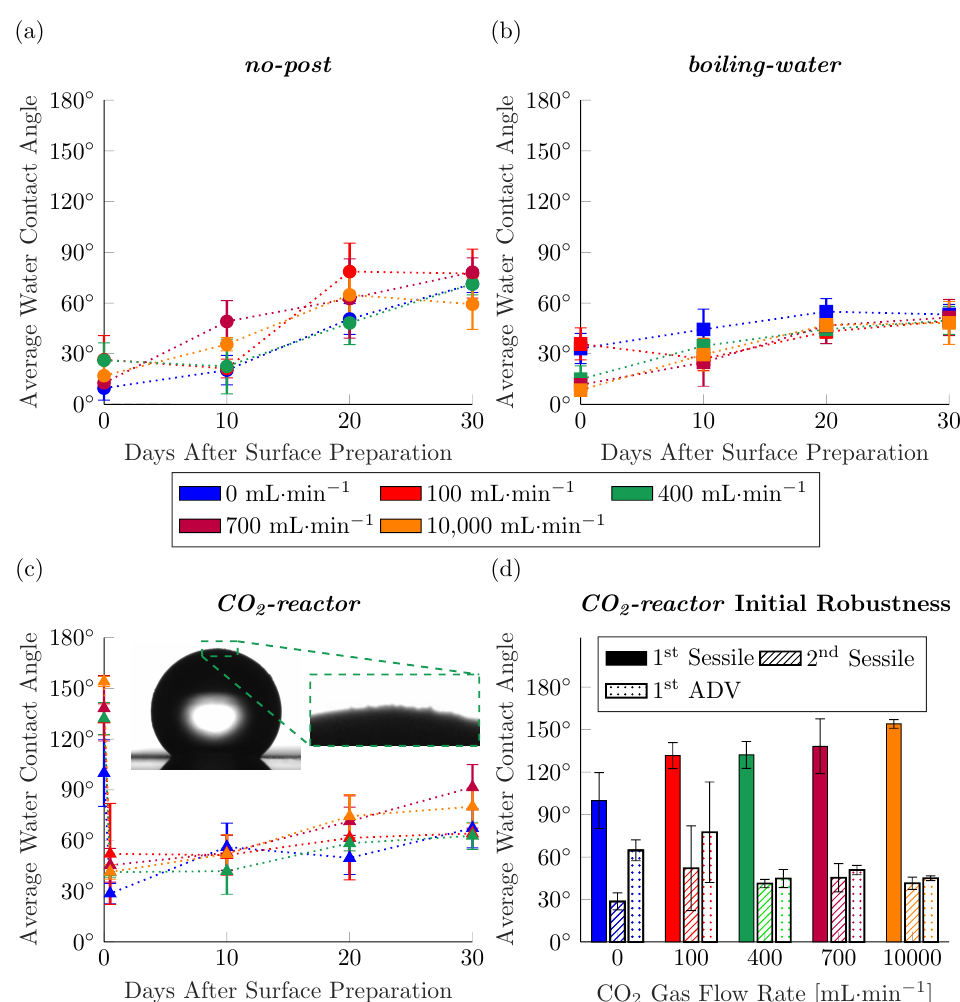
Figure 2. Average sessile water contact angle measurements taken over the 30 days following laser micromachining/post-processing on surfaces prepared with: ( a ) no post-processing step; ( b ) 48 h in boiling water; and ( c ) 48 h in the CO 2 reactor. Inset shows nanoparticle agglomerates on periphery of first sessile drop placed on CO 2 -reactor surfaces. ( d ) Comparison of the average: contact angle of the first sessile drop, contact angle of the second sessile drop, and advancing contact angle at day 0 on CO 2 -reactor